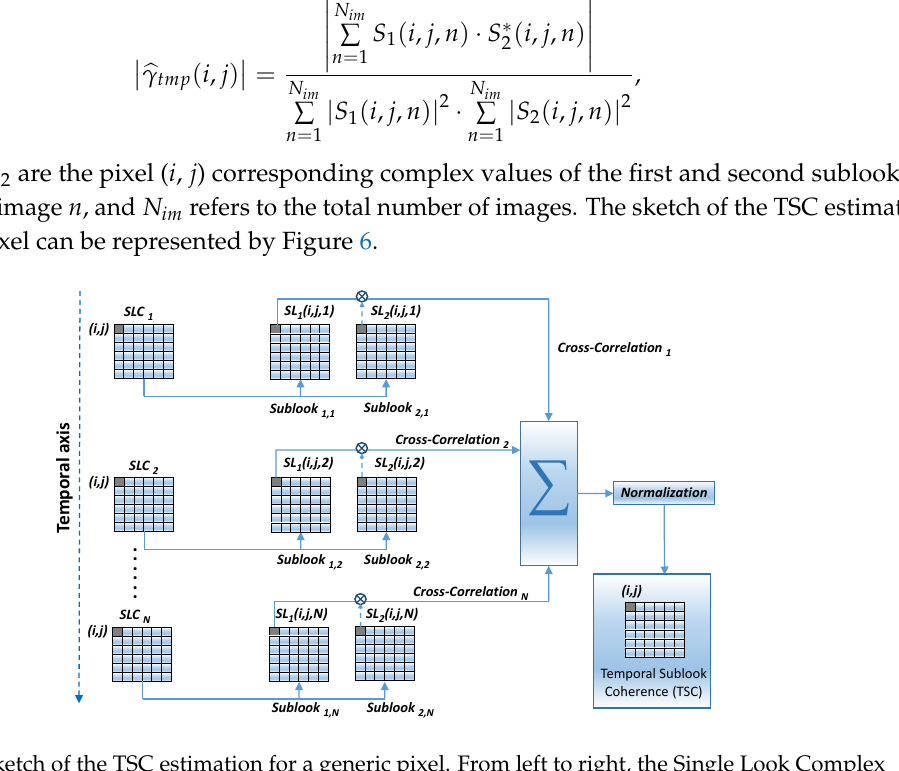
Figure 6. Sketch of the TSC estimation for a generic pixel. From left to right, the Single Look Complex (SLC) images of the dataset, the two sublooks generated from each image, coherence calculation and final TSC